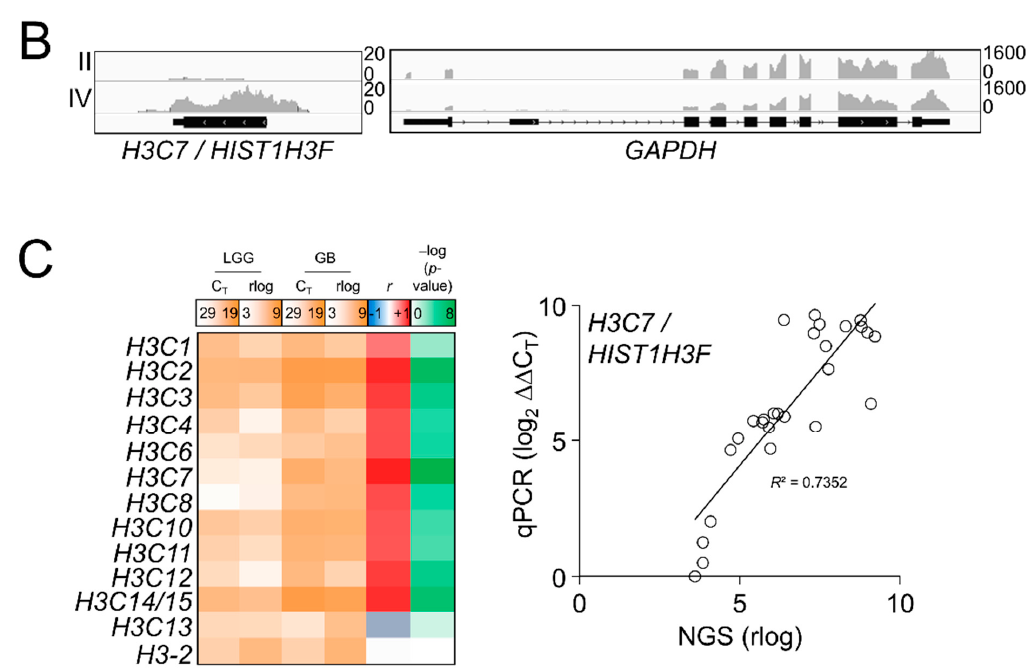
Figure 4. Differential mRNA expression of the canonical H3 variant ‐ encoding genes across gliomas of different grades.